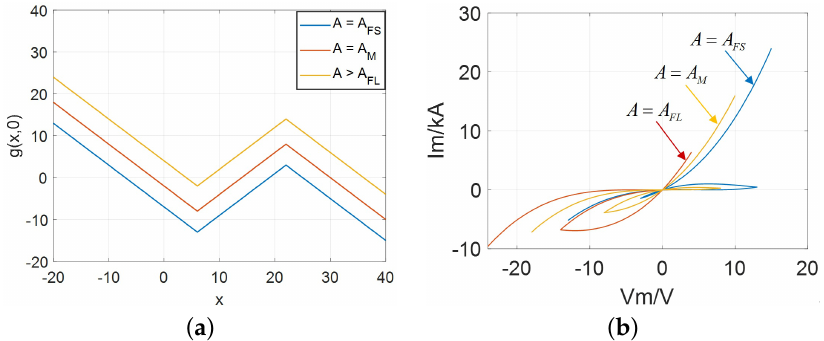
Figure 8. The DRM and phase locus with A FS , A M , and A FL : ( a ) DRMs along v = 0; ( b ) phase trajectory in Ivs . V